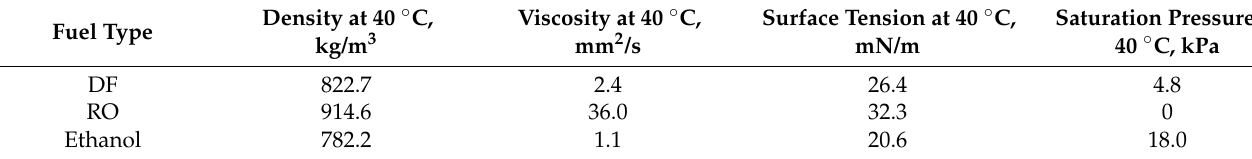
Table 5. Properties of DF, RO, and